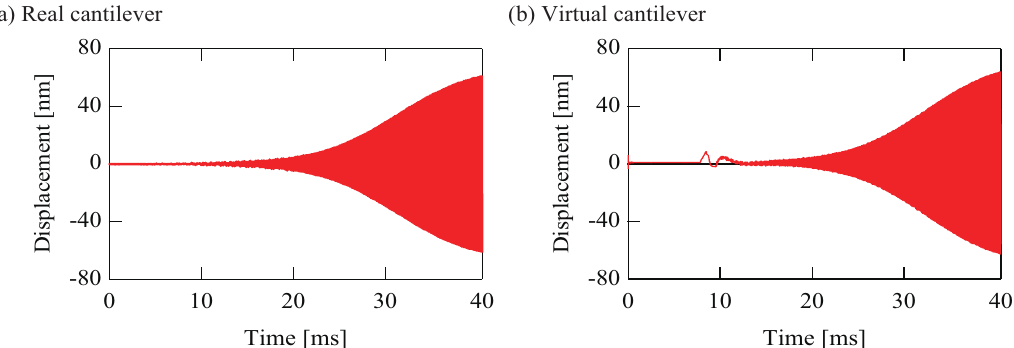
Figure 5. Time histories of self-excited virtually coupled cantilevers without mass samples; ( a ) Real microcantilever; ( b ) Virtual cantilever. The growing amplitudes of both the self-excited real and virtual cantilevers are nearly equal at each time. This result shows the physical parameters of the virtual cantilever can be made almost identical with those of the real microcantilever by tuning the impedance of the RLC